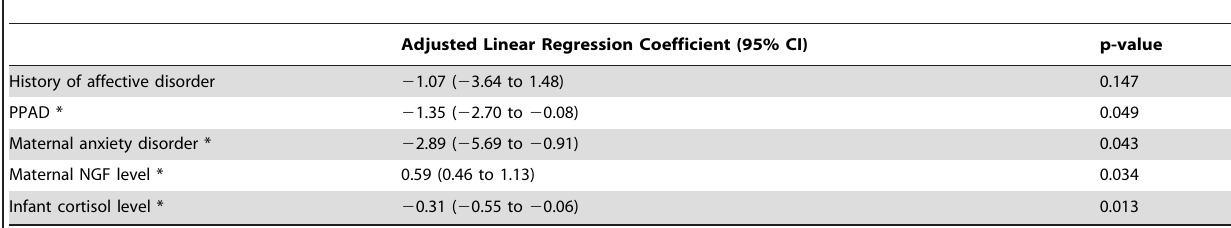
Table 3. Linear regression of infant neurobiological - motor development (AIMS Score) and: history of affective disorders, postpartum affective disorder (PPAD), maternal anxiety disorder, maternal NGF levels and infant cortisol